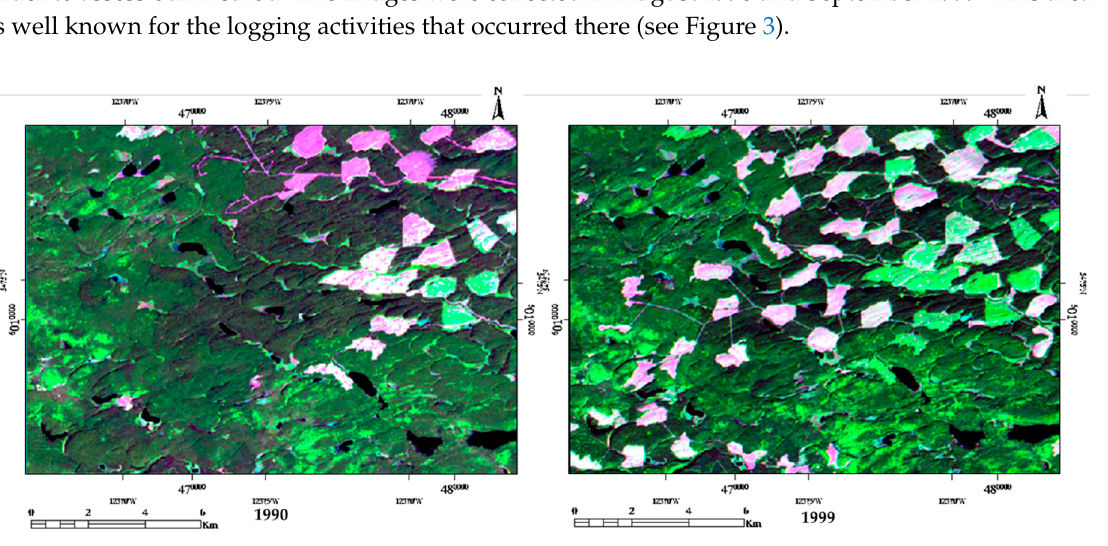
Figure 3. False-color (7-4-2) composite of satellite images acquired from Landsat imagery over Prince George, northern British Columbia, Canada.